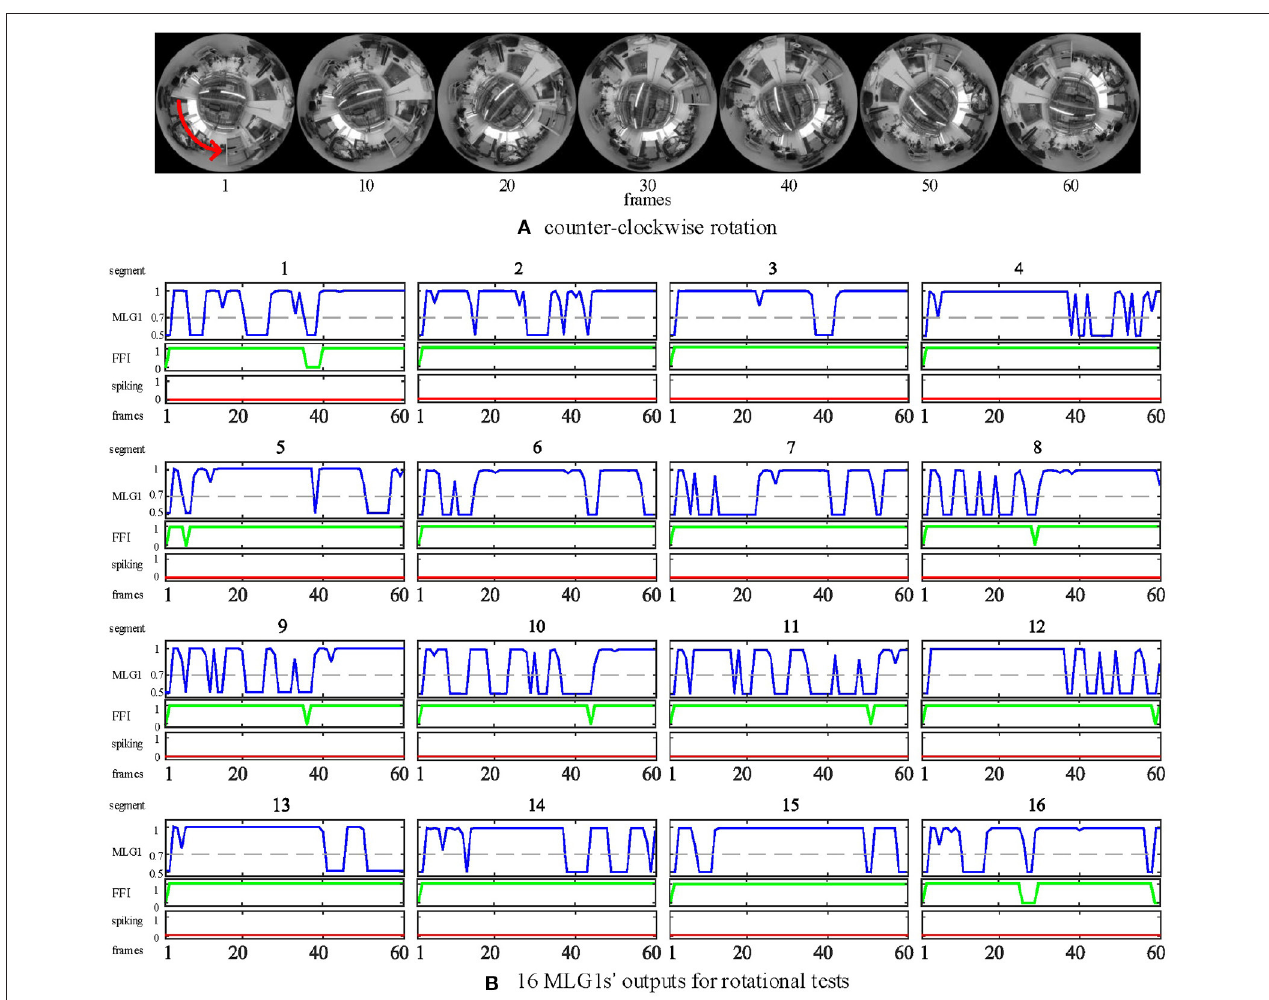
FIGURE 12 | Response of the proposed model to rotational motion. (A) counter-clockwise rotation. The panoramic camera rotates clockwise to simulate rotational movements. The red arrow is the direction of the stimuli resulting from camera rotation. (B) the outputs of rotational tests from all 16 MLG1s. The blue lines are the membrane potential outputs of MLG1 neurons. The green lines are the outputs of FFI. The red lines are spiking outputs from every MLG1 neuron, representing the collision warning. The FFI function can inhibit spikes caused by rotation efficiently. The number on the top of each subgraph corresponds to the segment number within the proposed structure in Figure 3A